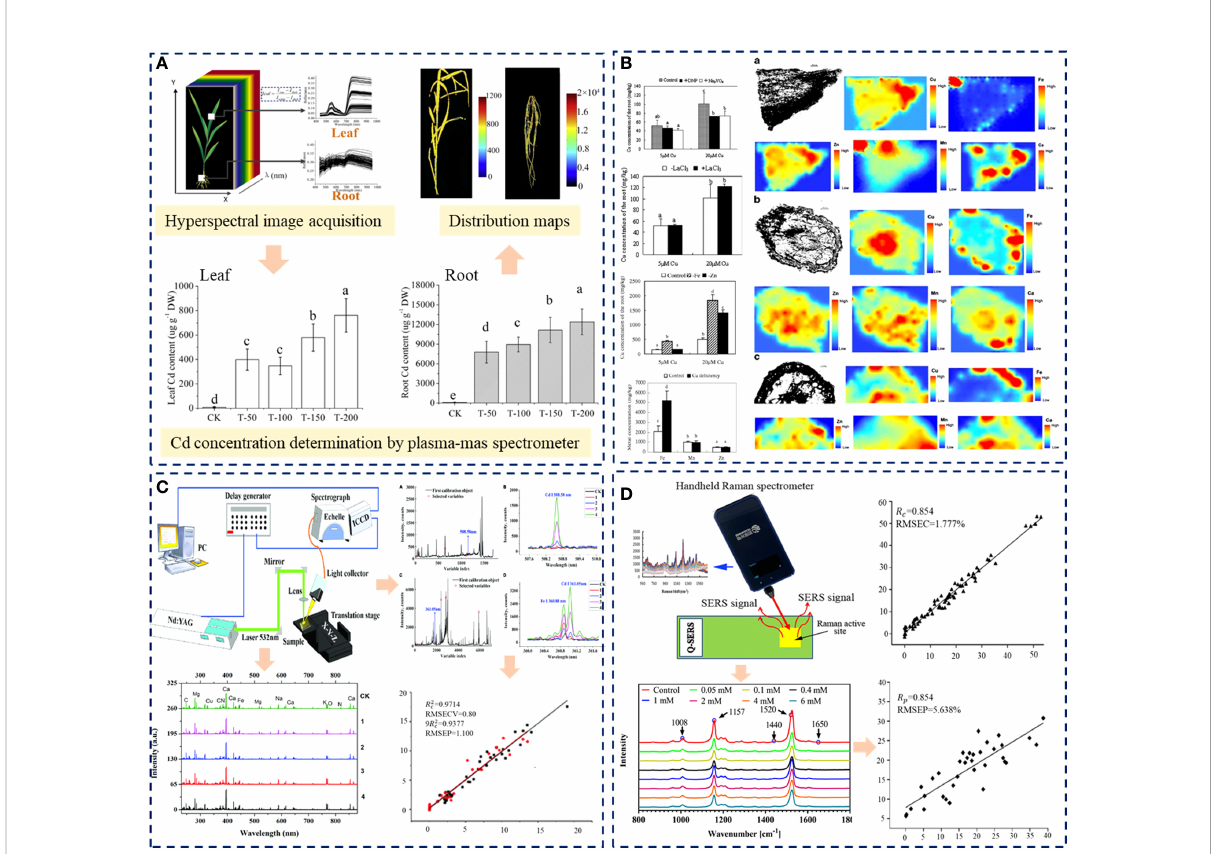
FIGURE 4 Application of spectral technology in detecting heavy metals in plant roots. (A) Rapid detection of cadmium and its distribution in Miscanthus sacchari fl orus by visible and near-infrared hyperspectral imaging. Different letters (a, b, c, d, e.) in each histogram indicate a signi fi cant difference at P<0.01. (B) The effects of copper absorption and metal distribution in Commelina communis root growing area were analyzed by XRF. (a) Longitudinal section around the meristem and metal locations; (b) Cross section of elongation tissue and metal locations; (c) Cross- section of non-growing tissue and metal locations. The scale bar of sections represents 50 m m. Different letters (a, b, c,d.) in each histogram indicate a signi fi cant difference at P<0.05. (C) Quantitative analysis of cadmium in tobacco roots was carried out by LIBS spectroscopy and